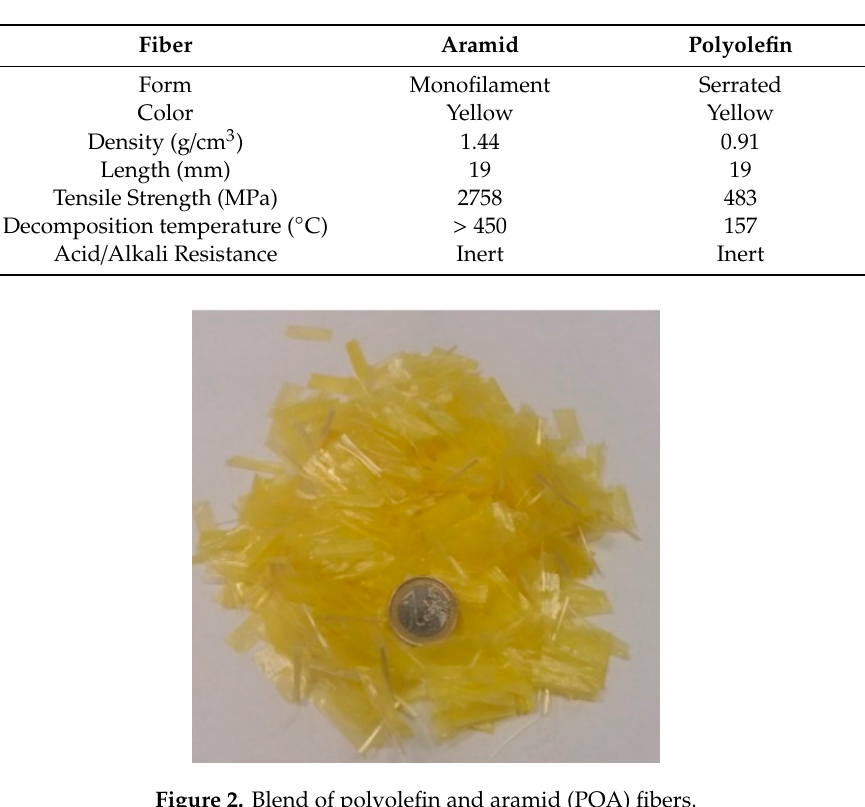
Table 5. Characteristics of POA fibers.